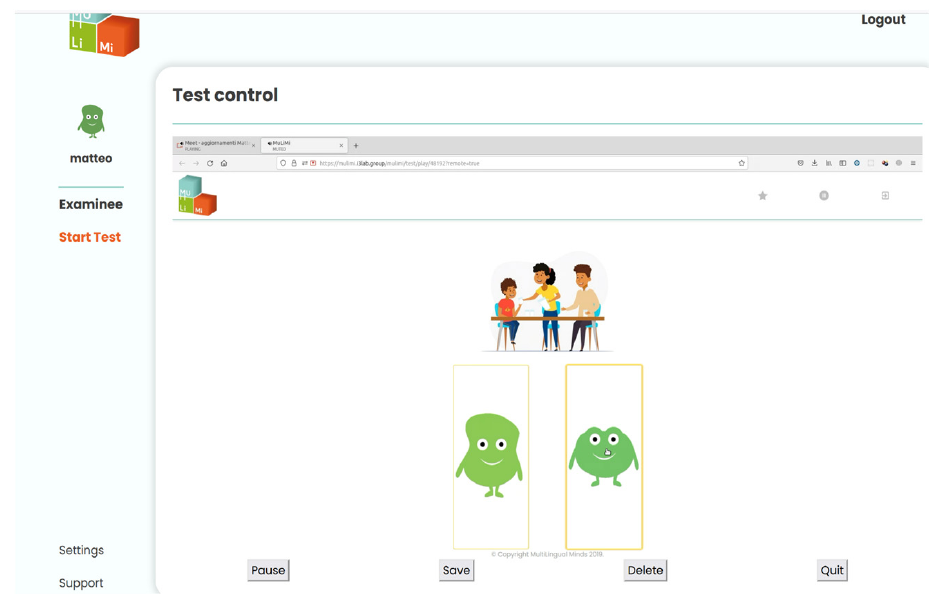
Figure 1. Examiner interface during remote administration of the WSIR subtest.